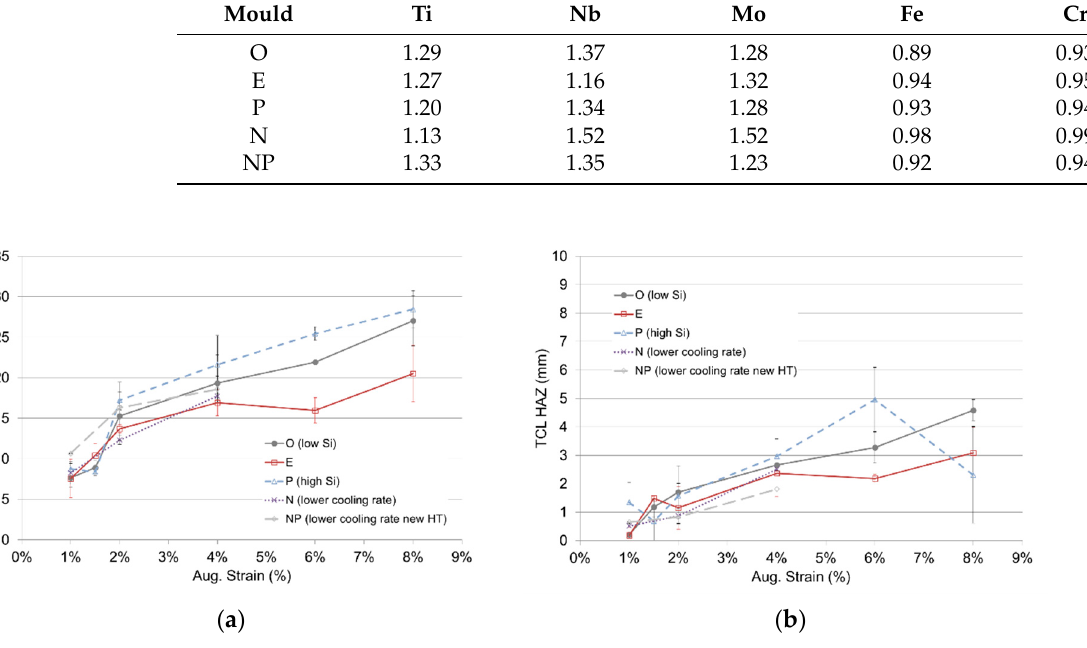
Figure 6. ( a ) FZ and ( b ) HAZ cracking response of five alloy 718 casting heats in LBW Varestraint test.